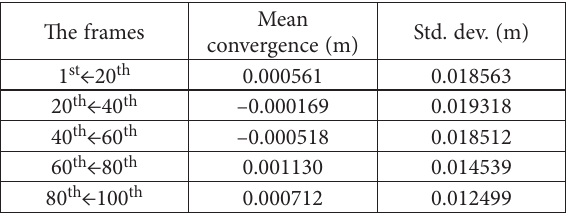
Table 3. The ICP results that were performed to SIFT results